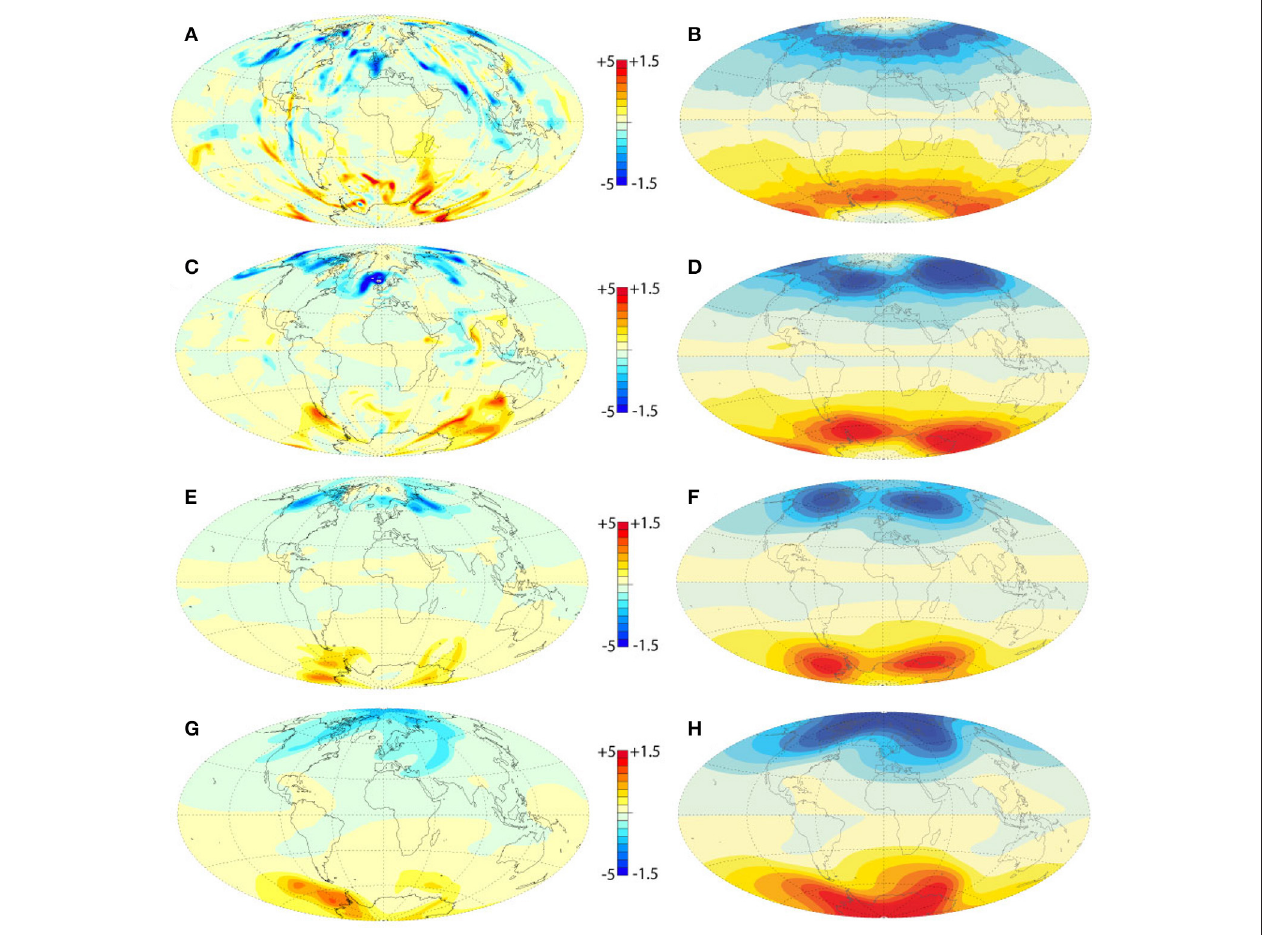
FIGURE 2 | Numerical dynamo radial magnetic field intensity B r at the outer boundary and Ra time average fields for S = 0; (C,D) Snapshot and time average fields for S = 0.1; (E,F) Snapshot and time average fields for S average fields for S = 0.3. Magnetic field intensities are in dimensionless Elsasser number